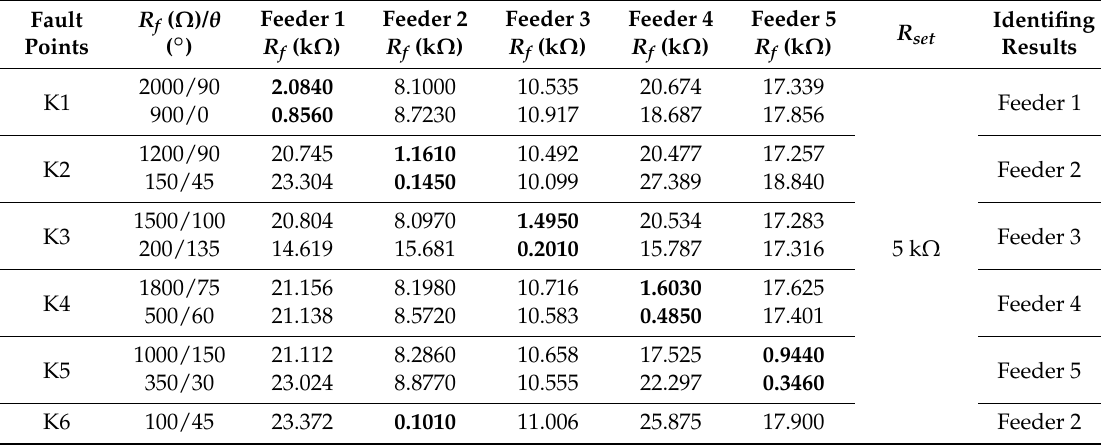
Table 1. Simulation results of the proposed method for faulty feeder identification under different fault